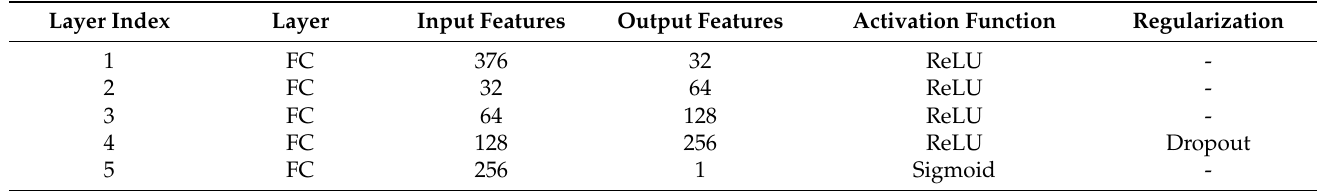
Table A1. ANN architecture. The layer that is highlighted in purple is used only for the regression and the classification approaches (not for the FSL approach). For the regression approach, we used no activation function and the activation function that is highlighted in green is used for the classification approach (not for the FSL approach).